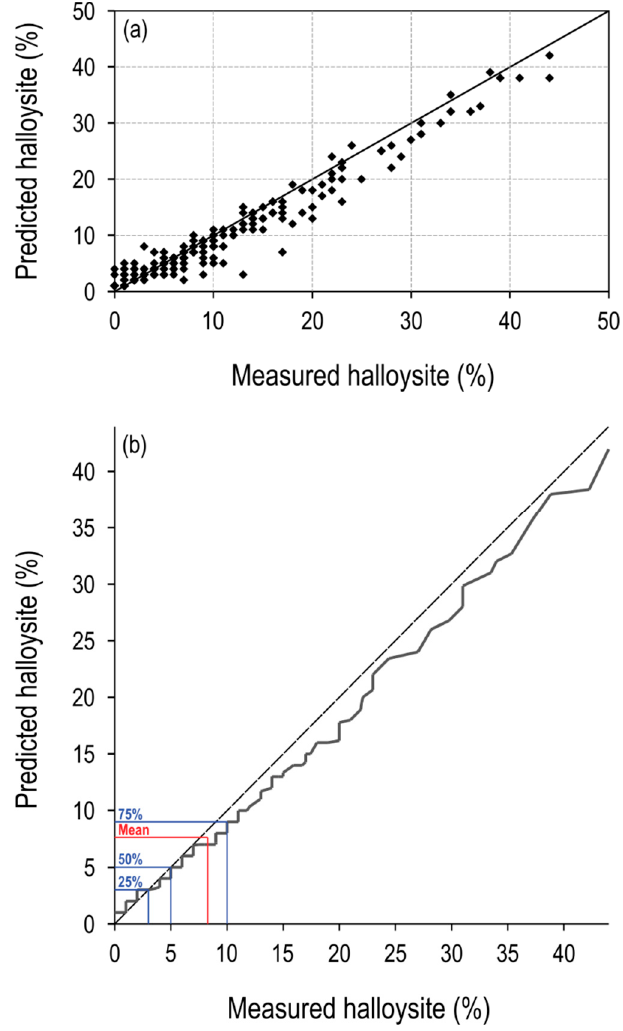
Figure 9. Halloysite ML results ( n = 316 samples); ( a ) measured halloysite (XRD) vs. predicted halloysite (ML); ( b ) as for ( a ) but for QQ plot; red = mean.